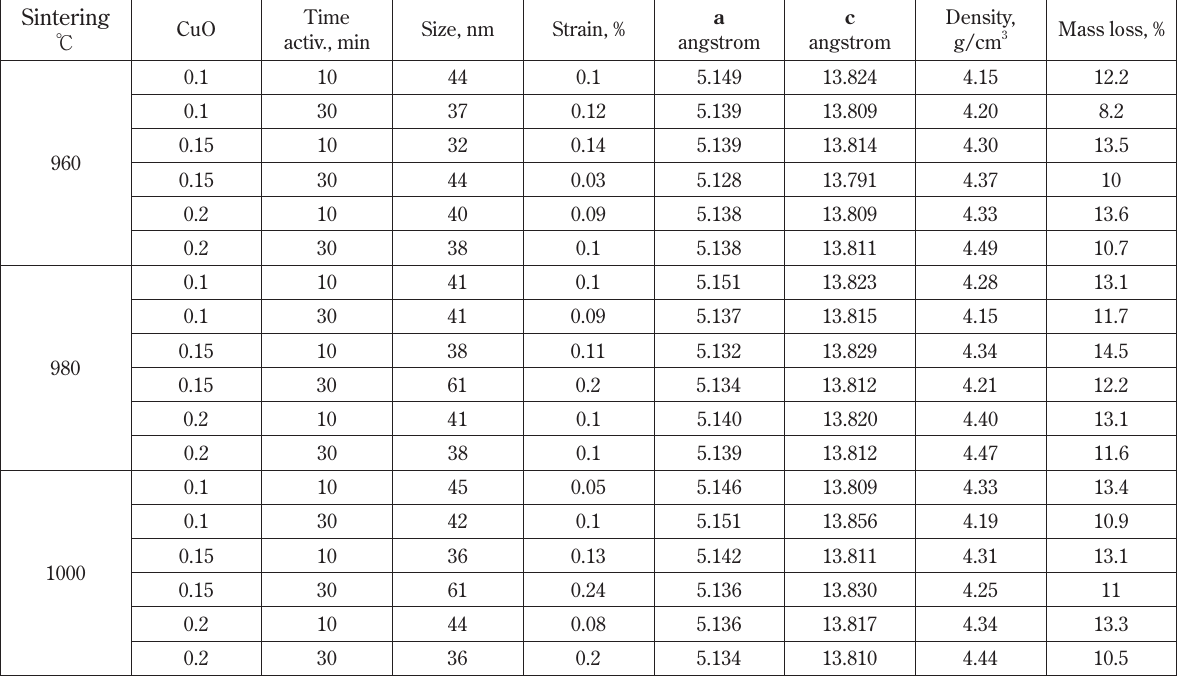
Table 2 Some results of the investigation of lithium niobate samples doped with copper oxide Sintering